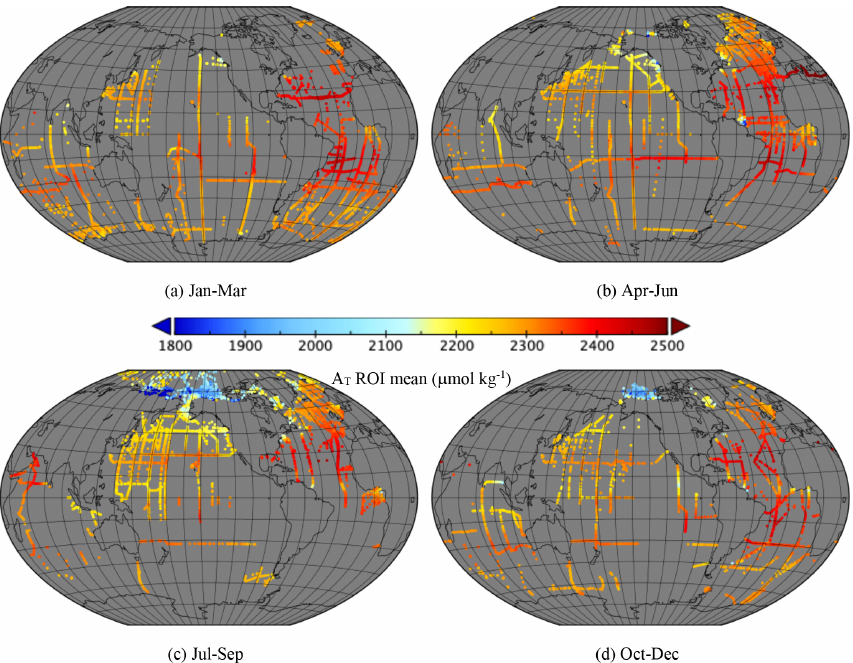
Figure 8. Mean A T (µmolkg − 1 ) divided into seasons. (a) January–March (3602 ROIs), (b) April–June (3682 ROIs), (c) July–September (3960 ROIs) and (d) October–December (2351